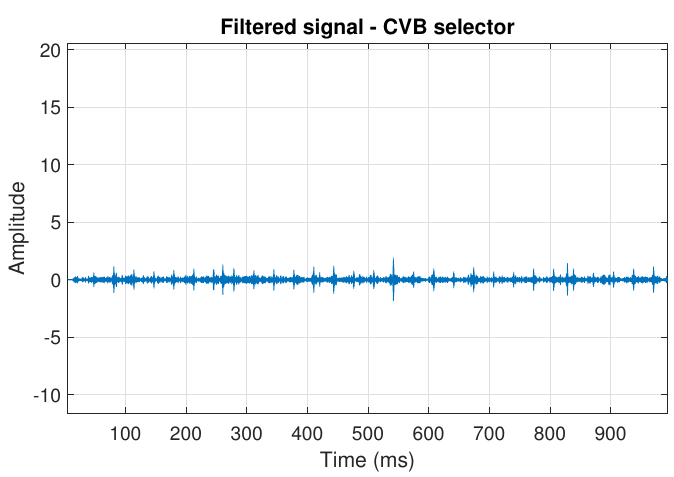
Figure 33. Spectrogram of filtered signal s 4 by Alpha selector.